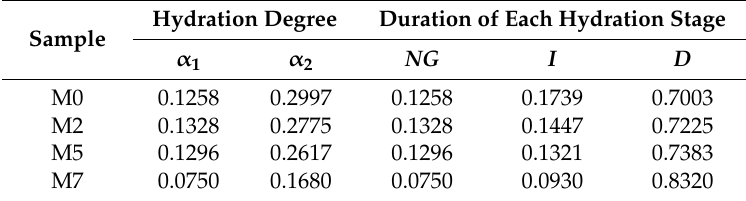
Table 6. Critical points of hydration degree and duration of each hydration